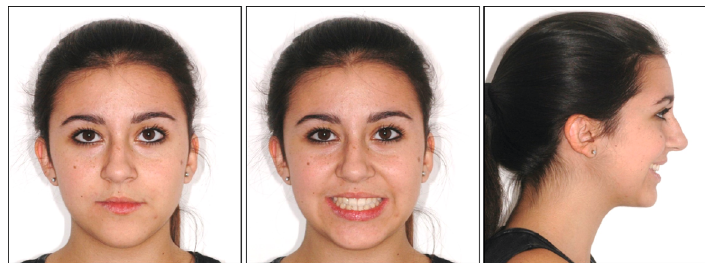
Figure 10: Facial photographs two years after orthodontic